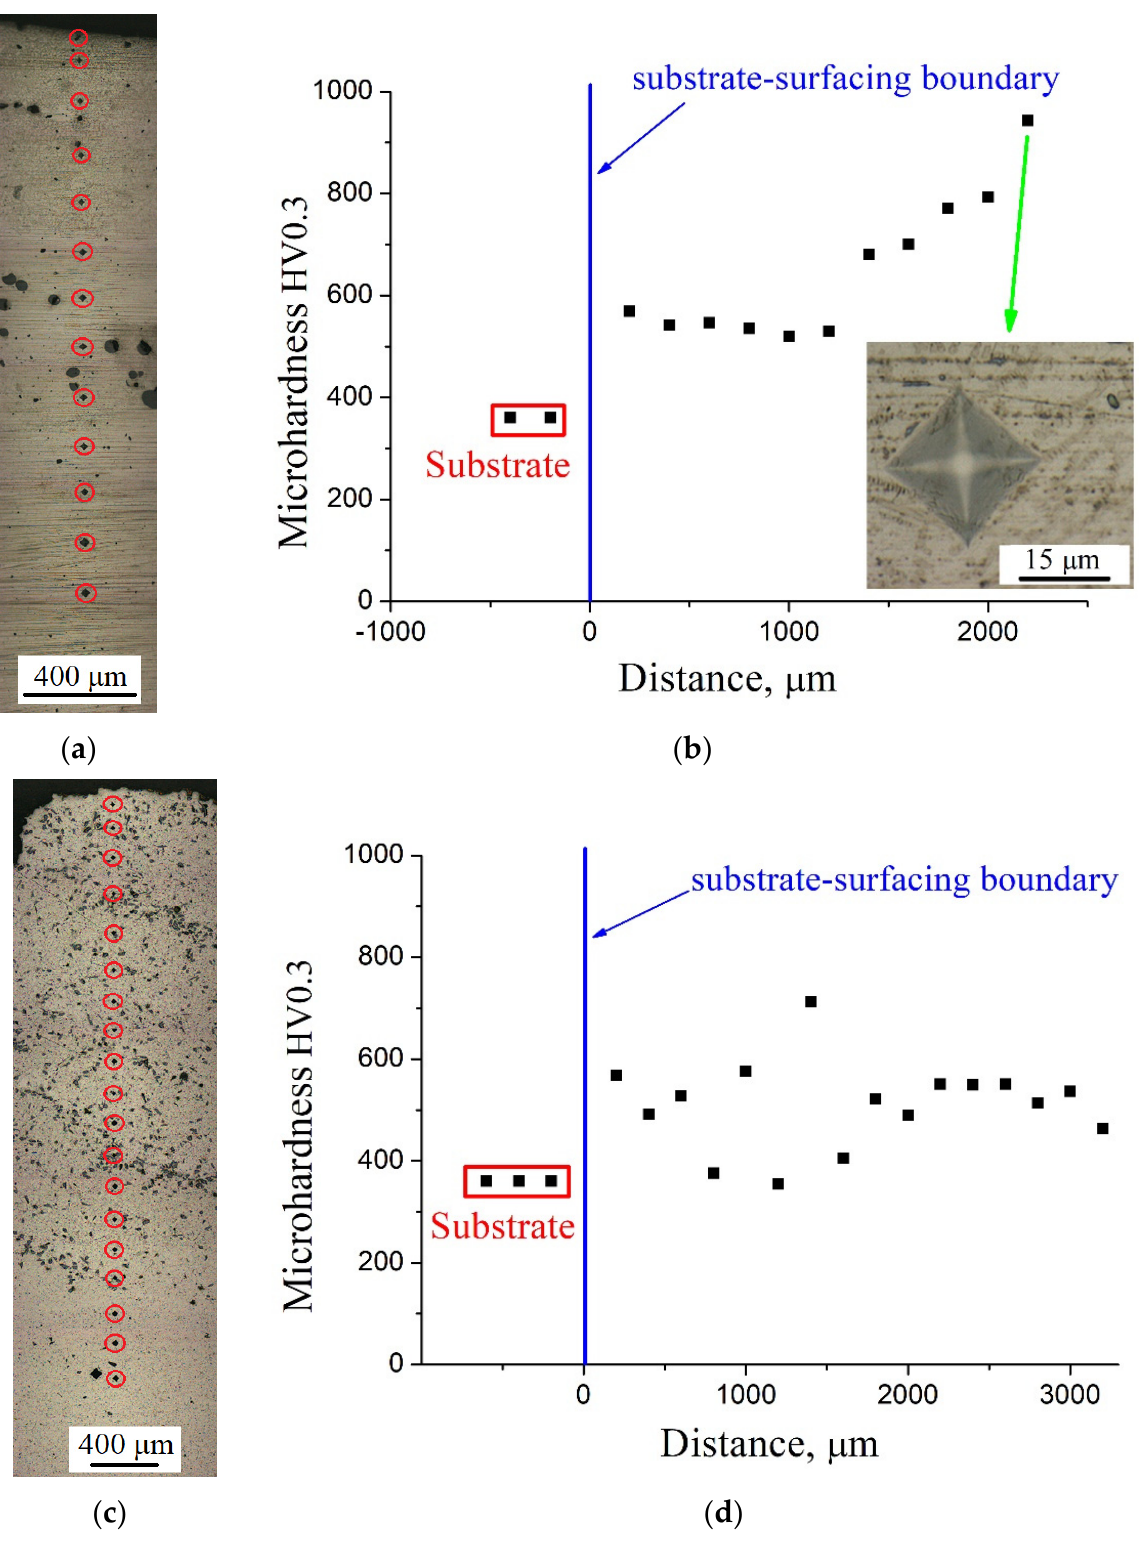
Figure 6. Photos of the indentor prints on the samples with the SiC fiber ( a ) and powder ( c ) and the dependence of the microhardness of the cermet coating on the graduate from the substrate for samples with the SiC fibers ( b ) and the SiC powder ( d ).